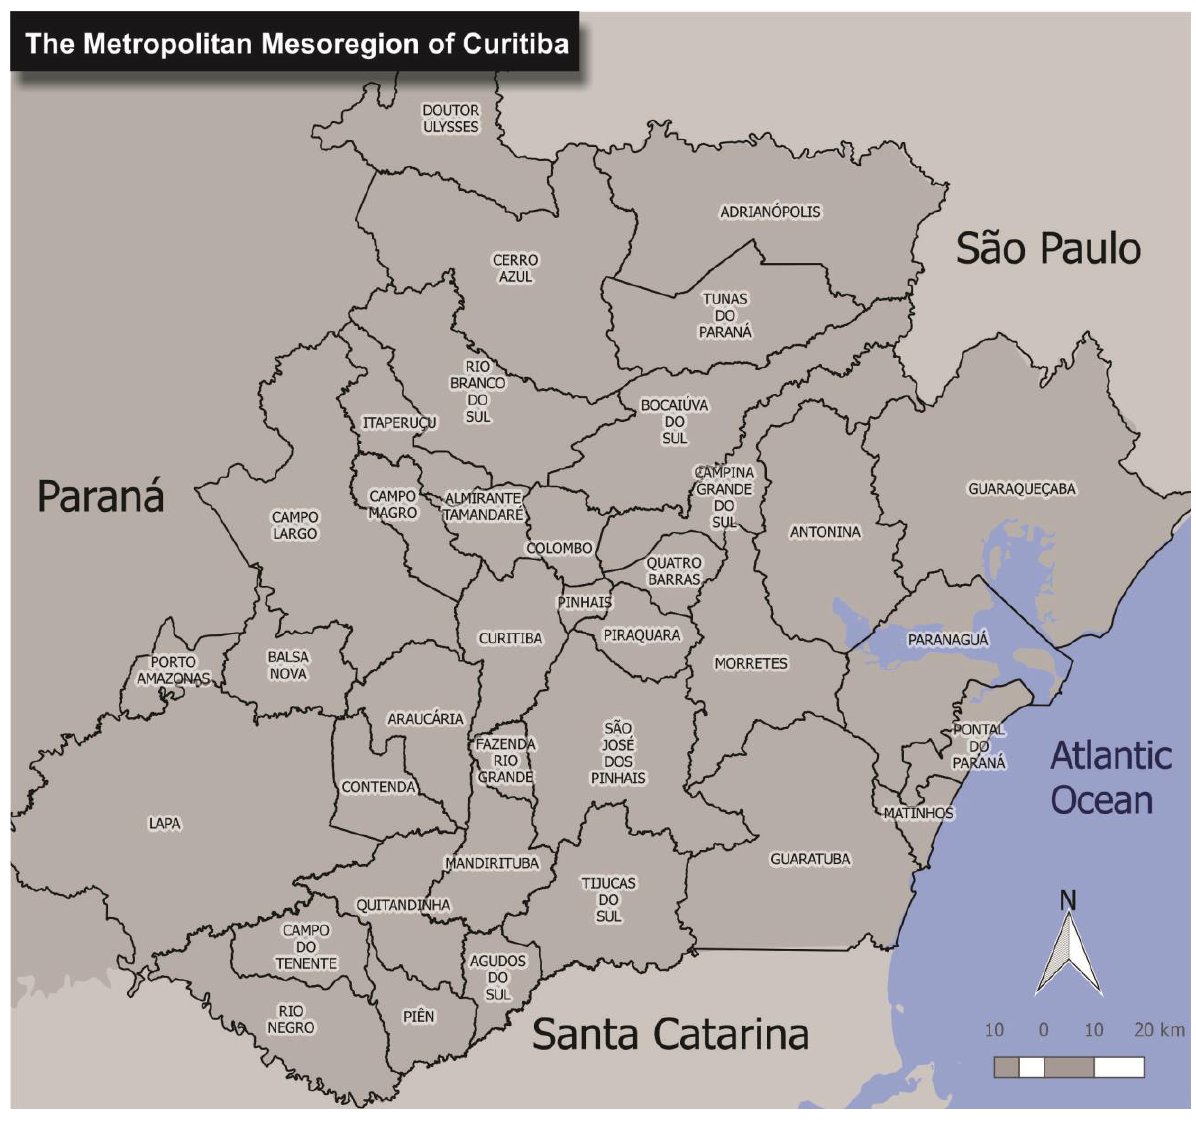
Figure 4. The selected municipalities comprising the Metropolitan Mesoregion of